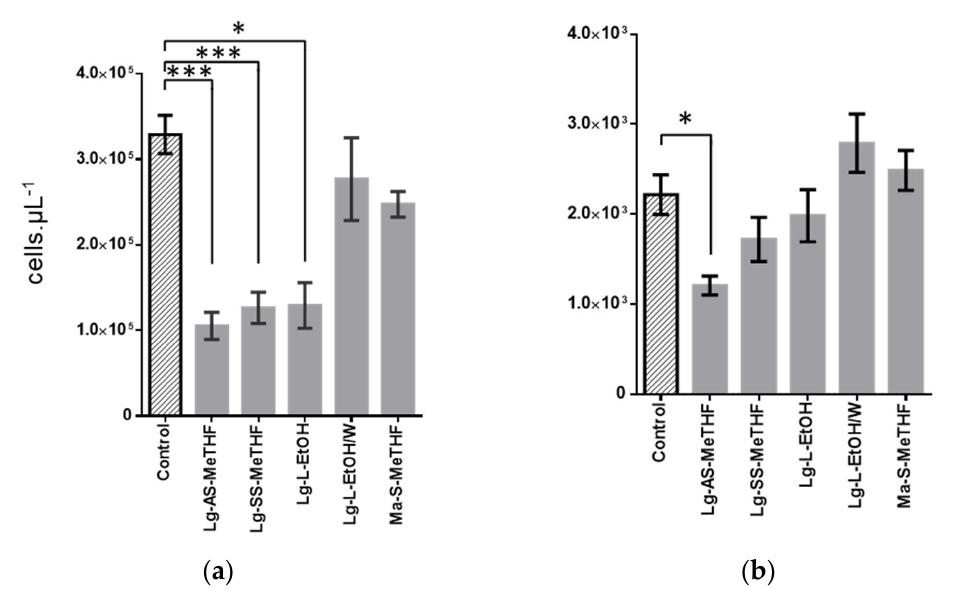
Figure 2. Inhibition activities of crude extracts at 100 μ g ∙ mL − 1 on 48 h old bispecies biofilm of C. albicans–S. aureus : ( a,b ) enumeration of each population in bispecies biofilm ( a ) S. aureus and ( b ) C. albicans by FCM after 24 h of treatment with the five selected crude extracts, compared with control (DMSO 2% treatment) (error bars in SEM). p ‐ value calculated by Dunn’s test were given with *: 0.05 > p ‐ value > 0.01; ***: 0.001 > p ‐